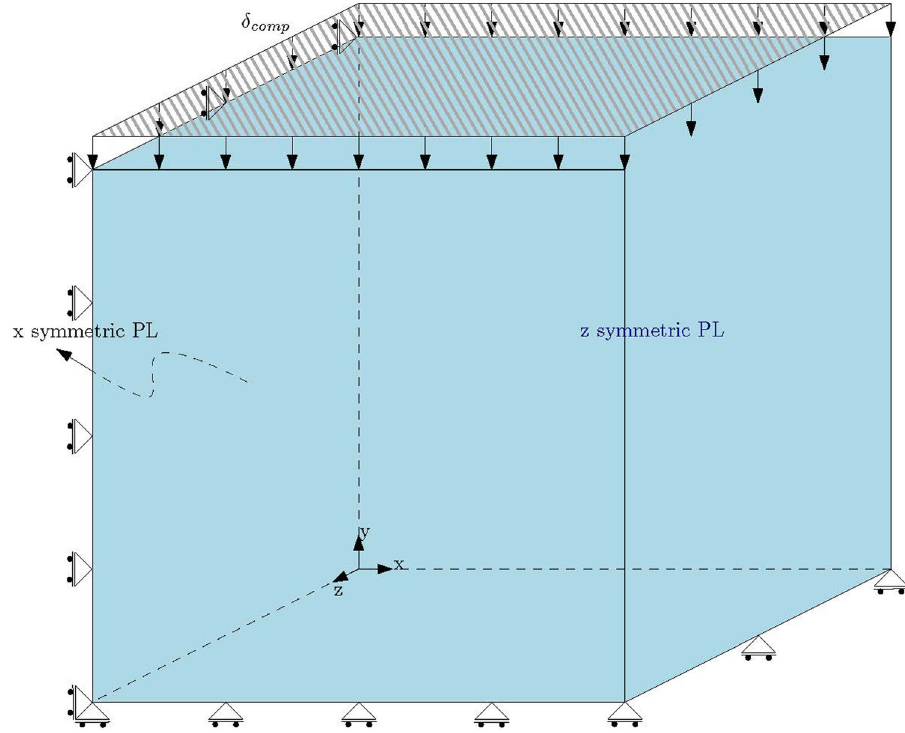
Fig. 2 Boundary and loading conditions for uniaxial compression test (symmetric planes are shown).